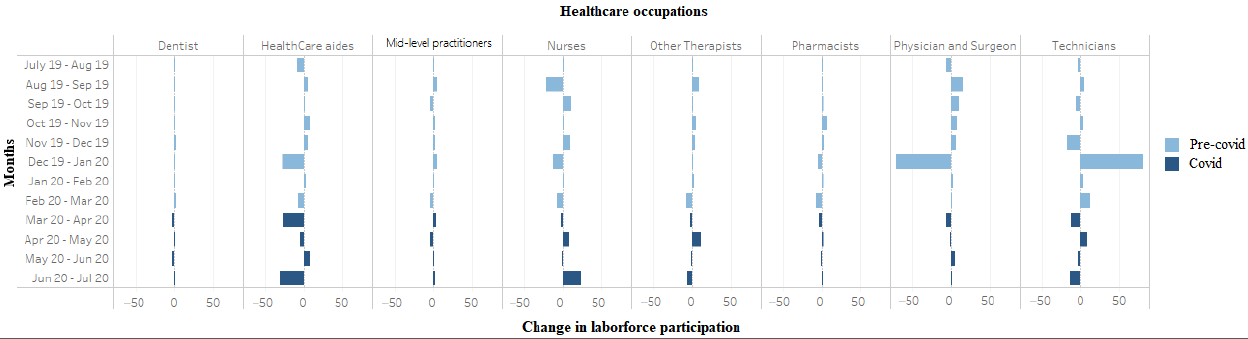
Figure 5. Change in labor force participation (in ten thousand) among workers in healthcare industries (July 2019–2020).